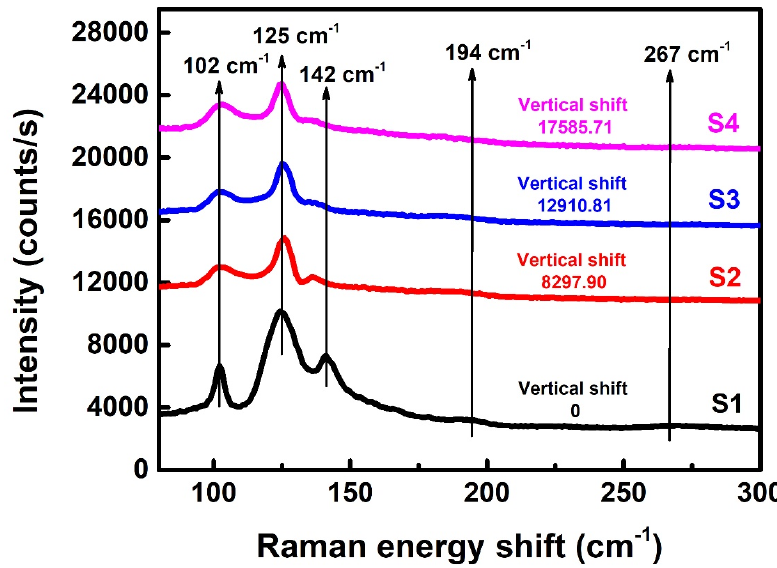
Figure 2. Raman spectra of Ta-doped InTe thin films S1–S4. Table 2. Raman peaks of Ta-doped InTe thin films and related phonon modes.